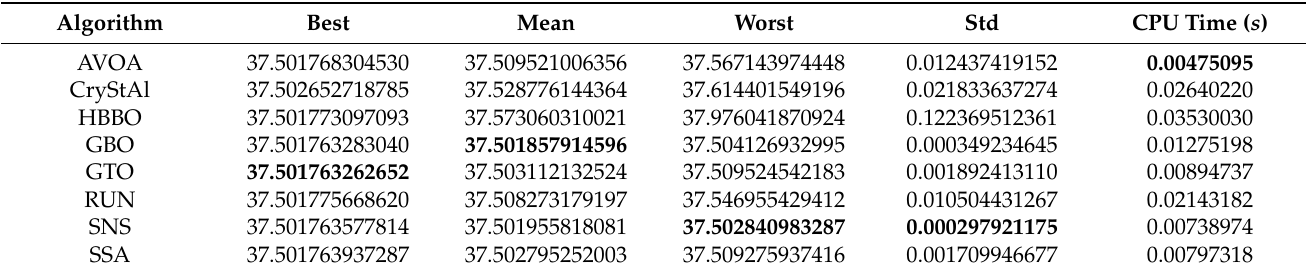
Table 6. Statistical findings of the bench-marked algorithms for the crane hook design